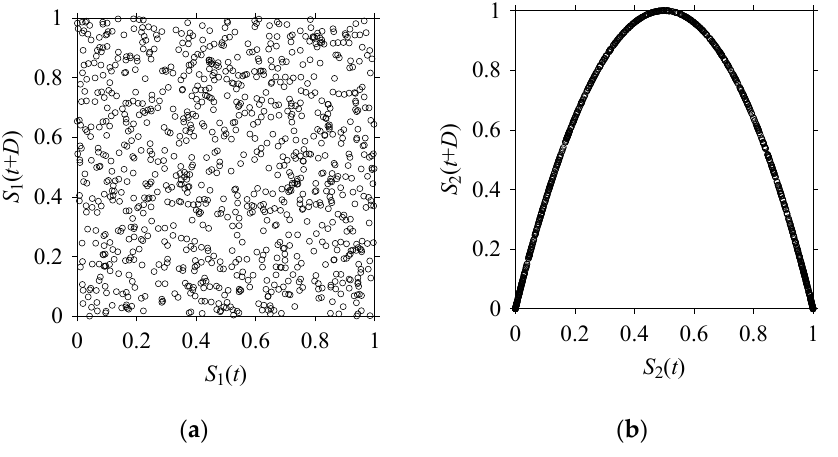
Figure 5. Delay maps (for d = 1) of: ( a ) S 1 , ( b ) S 2 .